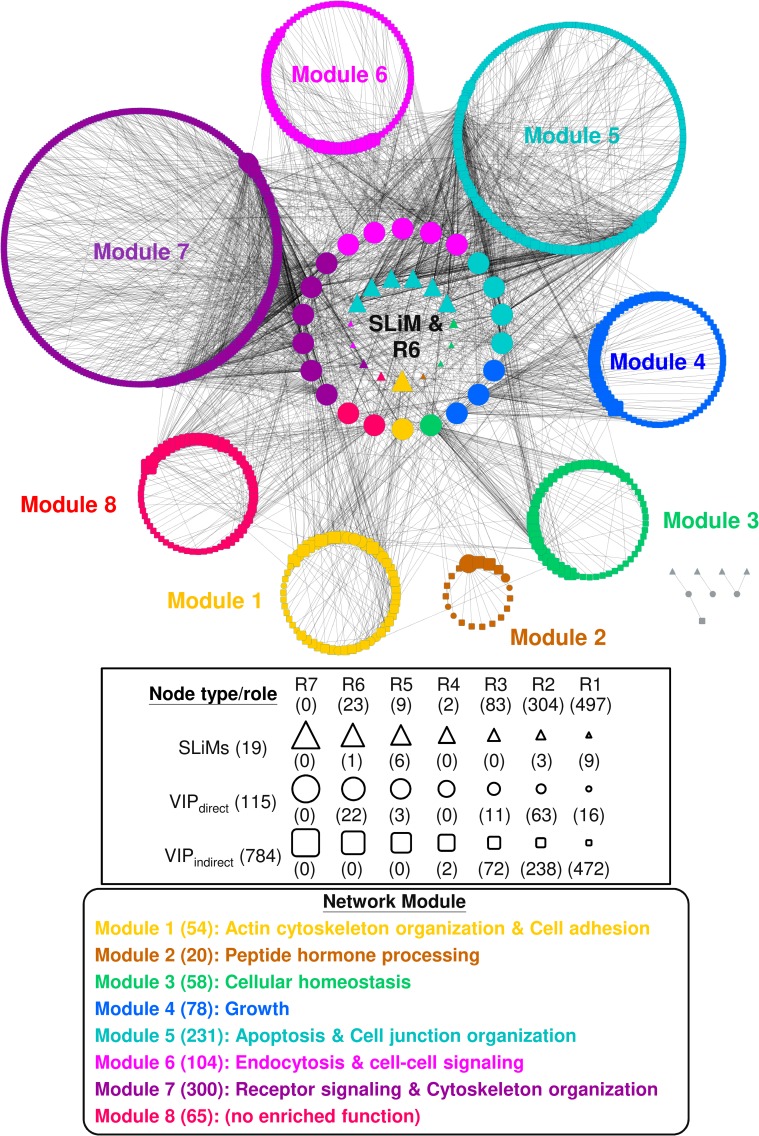
Modules and roles of the nodes of the HCV-Human PPI network.The network was produced using the procedures described in Fig 1A–1C, with the modules and the roles of network nodes determined by NetCarto (see Methods). The three types of network nodes are represented as triangles for SLiMs; circles for VIPsdirect; and squares for VIPsindirect. Their network roles (R7 to R1) are depicted as symbols of decreasing size. All nodes are color-coded according to their module. A representative function(s) of each module was derived from an enrichment analysis of GO terms associated with its nodes followed by a summary of Revigo representatives [21] (see Methods and S1 Table). Colored in gray in the lower right corner are eight isolated nodes.